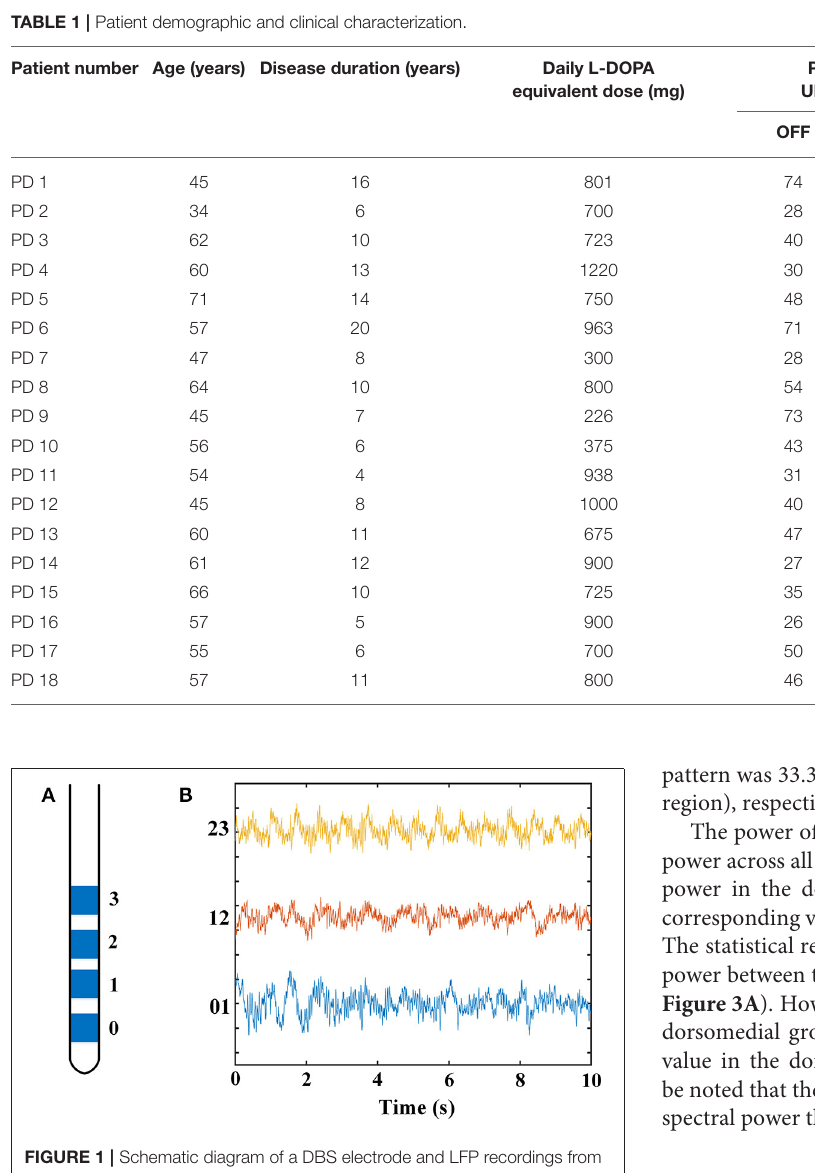
FIGURE 1 | Schematic diagram of a DBS electrode and LFP recordings from a DSB electrode in STN. (A) Schematics showing the quadripolar electrode from the anterior view. Contacts 0 and 3 indicating the contacts at bottom and top, respectively. (B) Example of LFP signals from all three contact pairs of an electrode located in STN. The X-axis represents time (s), and the Y-axis represents the names of the three contact pairs. Blue line: LFP from contact pair 0–1; red line: LFP from contact pair 1–2; yellow line: LFP from contact pair 2–3. DBS, deep brain stimulation; LFP, local field potential; STN, subthalamic